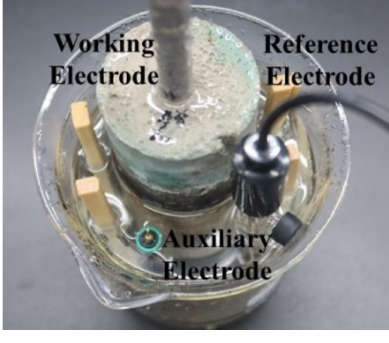
Figure 2. Test specimen